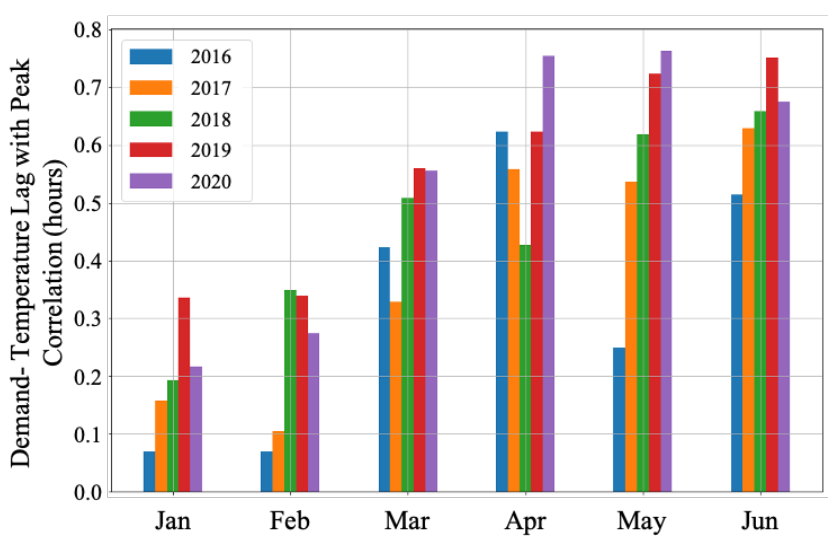
Figure 4. The correlation between the electricity demand and temperature from 2016 to 2020.